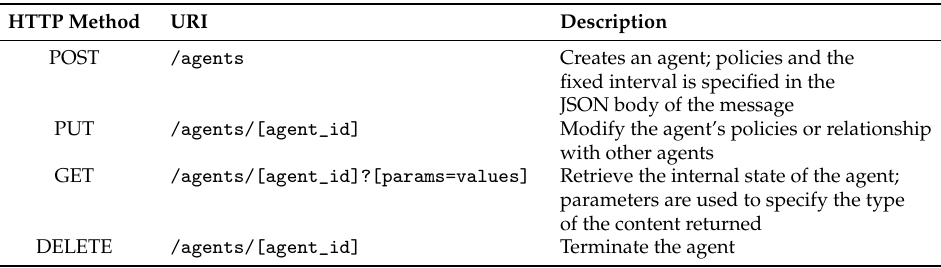
Table 2. Agent Manager API for agent life-cycle.